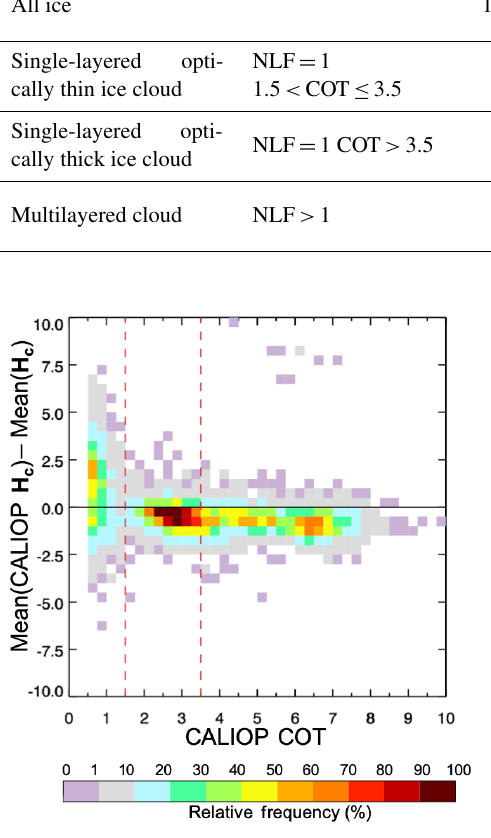
Figure 10. A frequency of biases of mean( H c ) from mean(CALIOP H c ) as a function of CALIOP COT during August 2015. The mean(CALIOP H c ) implies the average of the upper and lower cloud boundaries, simply defined as 0 . 5 · ( CALIOP CTH + CALIOP CBH ) . The mean( H c ) is also the average of cloud heights by our method, defined as 0 . 5 · ( min (H c ) + max (H c )) . The red dotted lines are references for single-layered optically thin (1.5 < COT ≤ 3.5) and optically thick (COT > 3.5) ice clouds in this